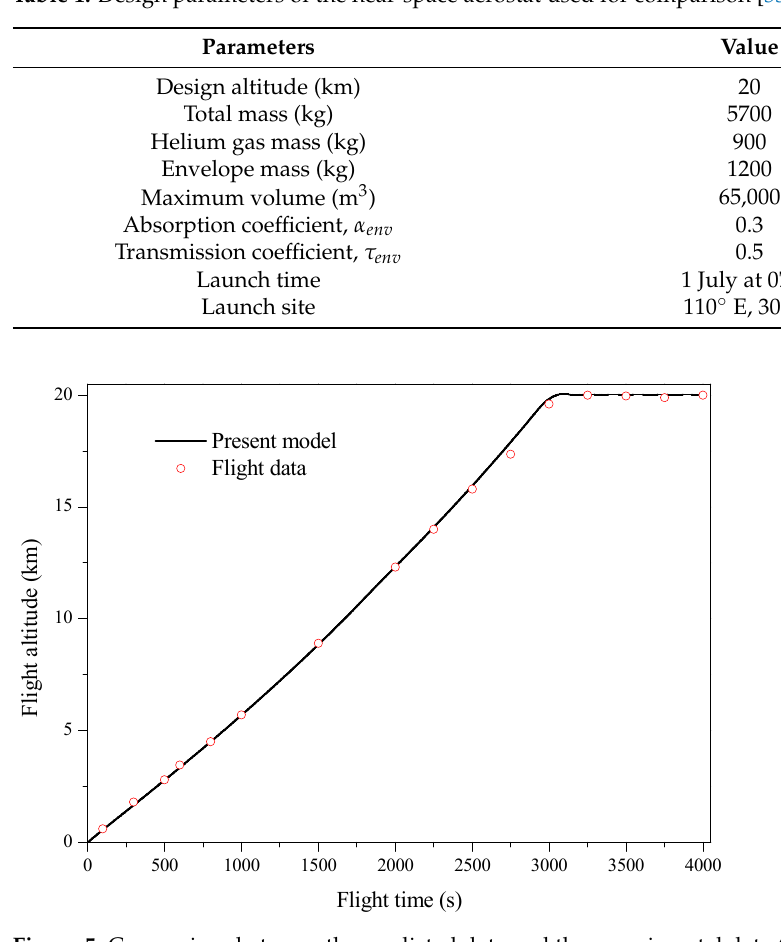
Figure 6. Comparison between the predicted data and the experimental data (lifting gas tempera- ture).